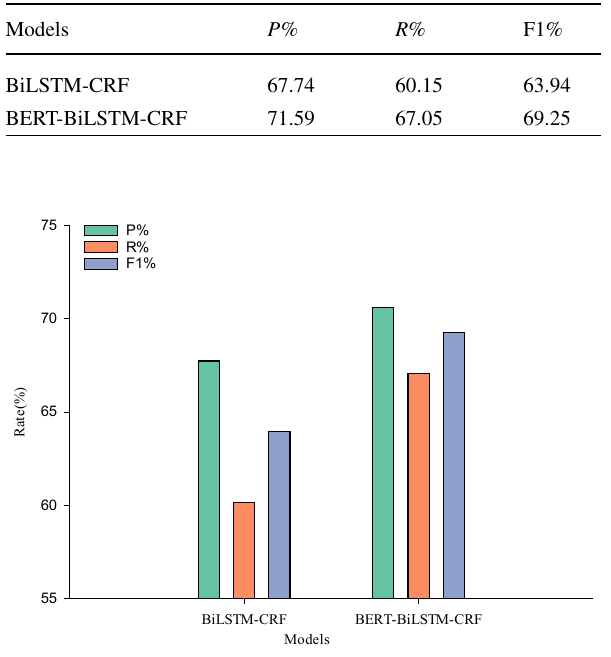
representation layer and context coding layer compared with the benchmark model of sequence annotation BiLSTM-CRF. Therefore, the performance of the model before and after improvement will be compared and analyzed.